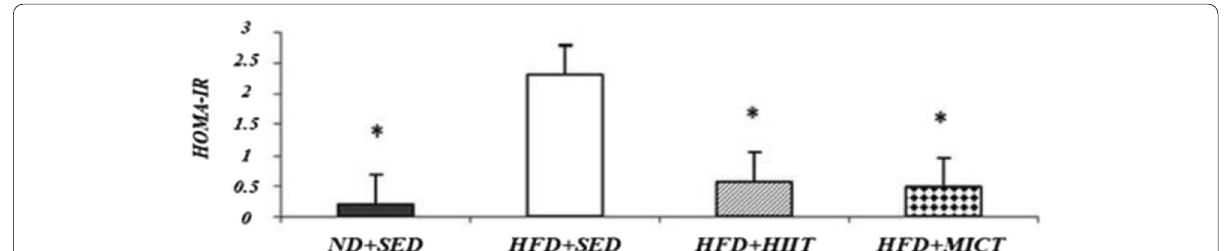
Fig. 1 The comparison of HOMA‑IR among the groups. * signs of significant difference with the HFD